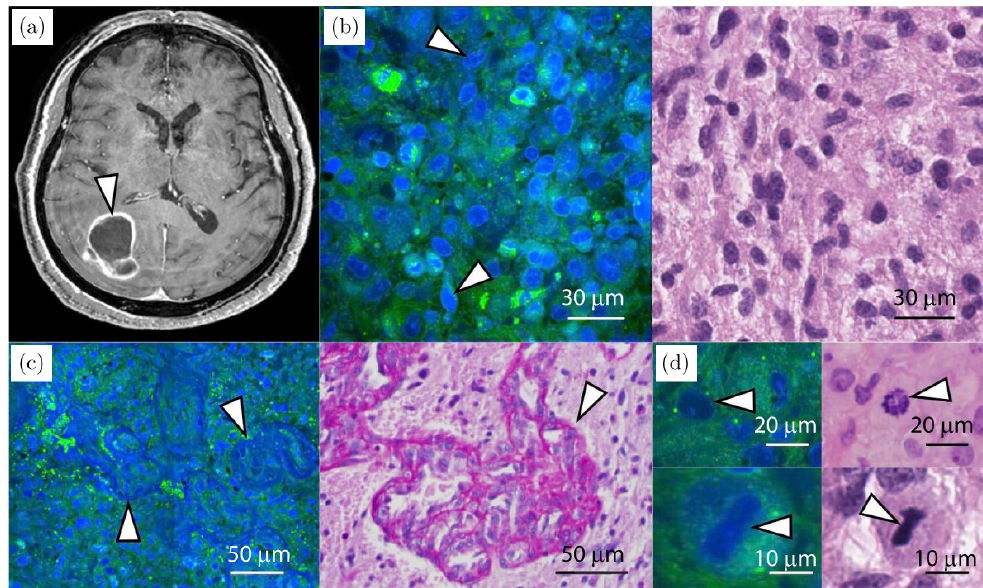
Fig. 5. SRS images of human GBM tissues: (a) MRI with enhanced ring showing GBM tissues (arrow). SRS and H&E images of GBM tissues with diagnostic information of (b) hypercellularity and nuclear atypia, (c) abnormal microvascular proliferation, and (d) mitotic